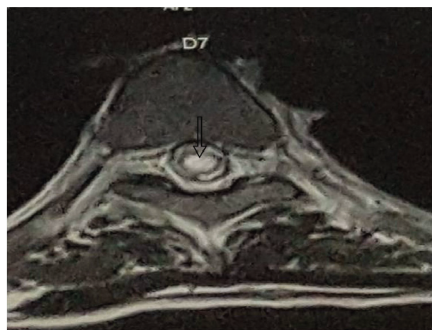
Figure 2: Axial T2W sagittal section showing D7 intramedullary hyperintensity.